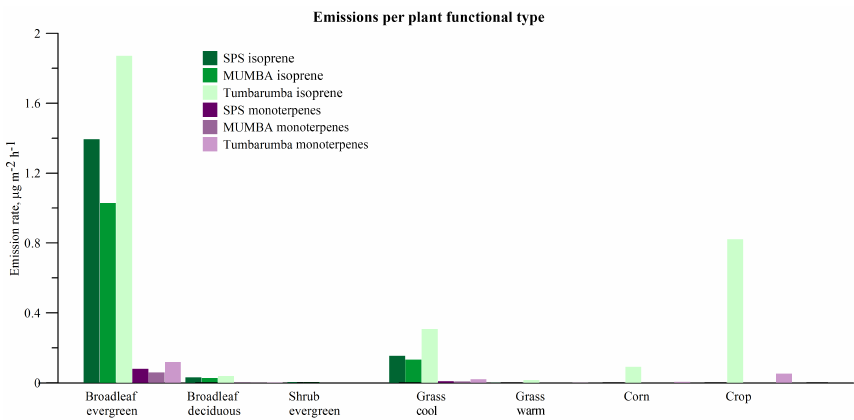
Figure 4. Emission rates of isoprene and monoterpenes per PFT within each campaign’s inner domain (180km × 180km).